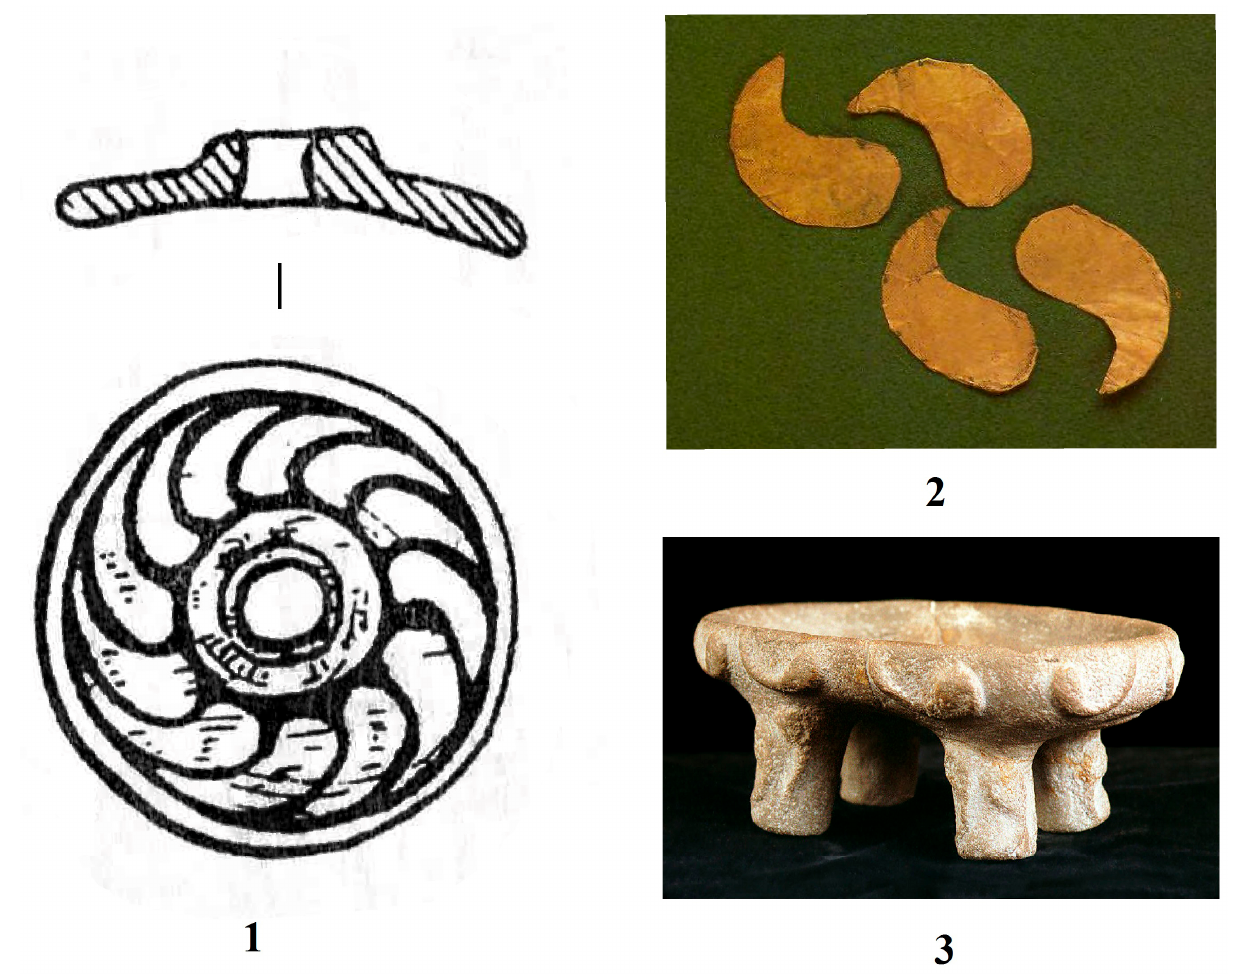
Figure 9. 1—Suglug-Khem burial ground, Tuva; 2—Tenlik barrow, southeastern Kazakhstan (Semirech’ie); 3—Chu Valley (1—after V. A. Semenov (2003); 2—after Akishev and Akishev (1983); 3—after A. N. Bernshtam (1952)).